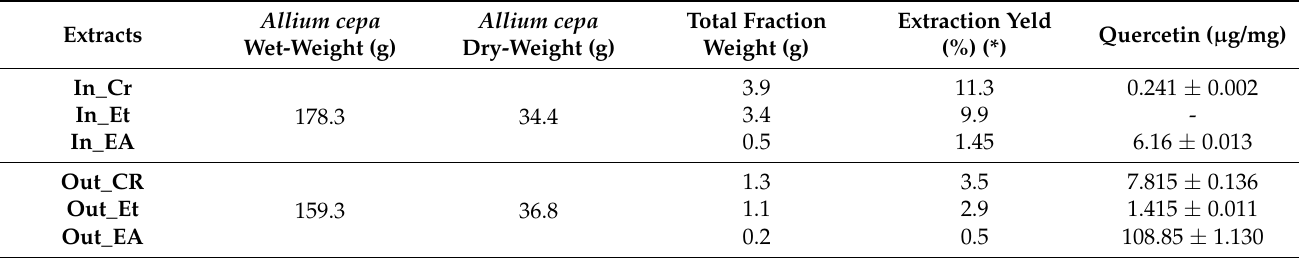
Table 1. Extraction yield of Allium cepa extracts and quercetin